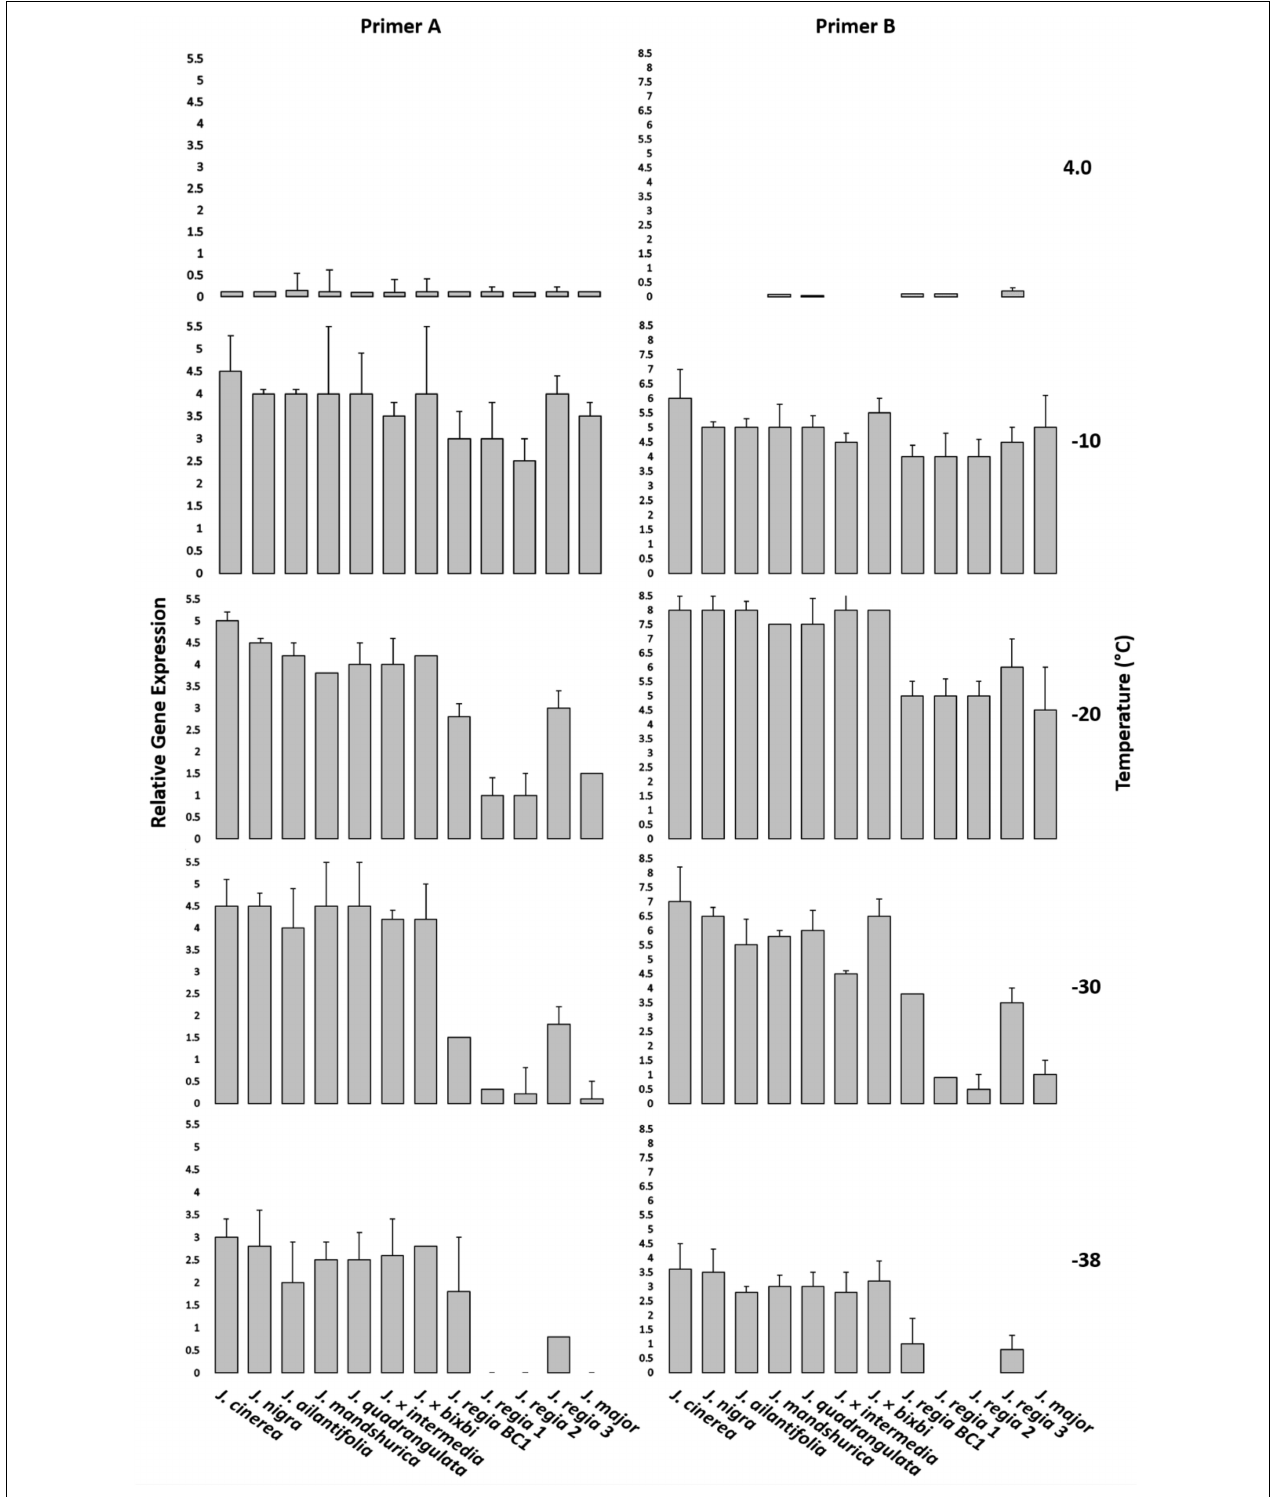
FIGURE 4 | qPCR analysis. Two candidate primers for Juglans cold hardy genes were used to ascertain relative gene expression of twelve Juglans species and interspecific hybrid samples at 4, –10, –20, –30, and –38 ◦ C. Error bars represent standard error of the mean for three biological replicates (three technical replicates). All J. regia used for gene expression analysis were obtained from Indiana and J. regia from California was excluded from this analysis. J. major was obtained from Indiana.